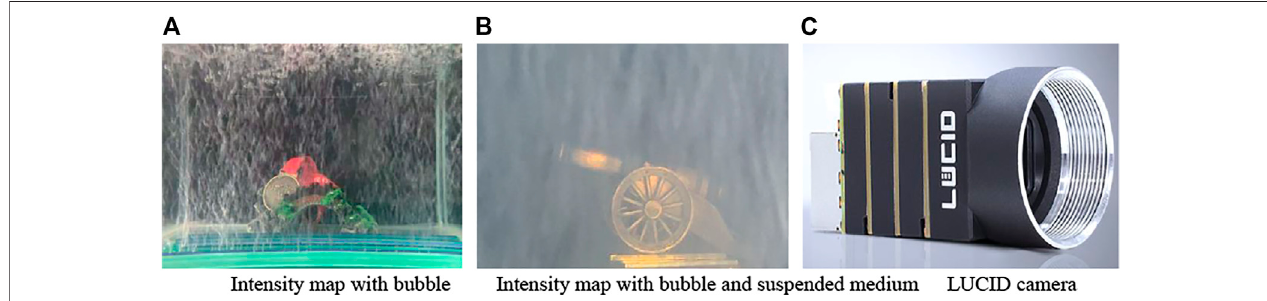
FIGURE 11 | Diagram of dynamic turbid underwater complex environment and experimental scene. (A) Intensity map with bubble (B) Intensity map with bubble and suspended medium (C) LUCID camera.